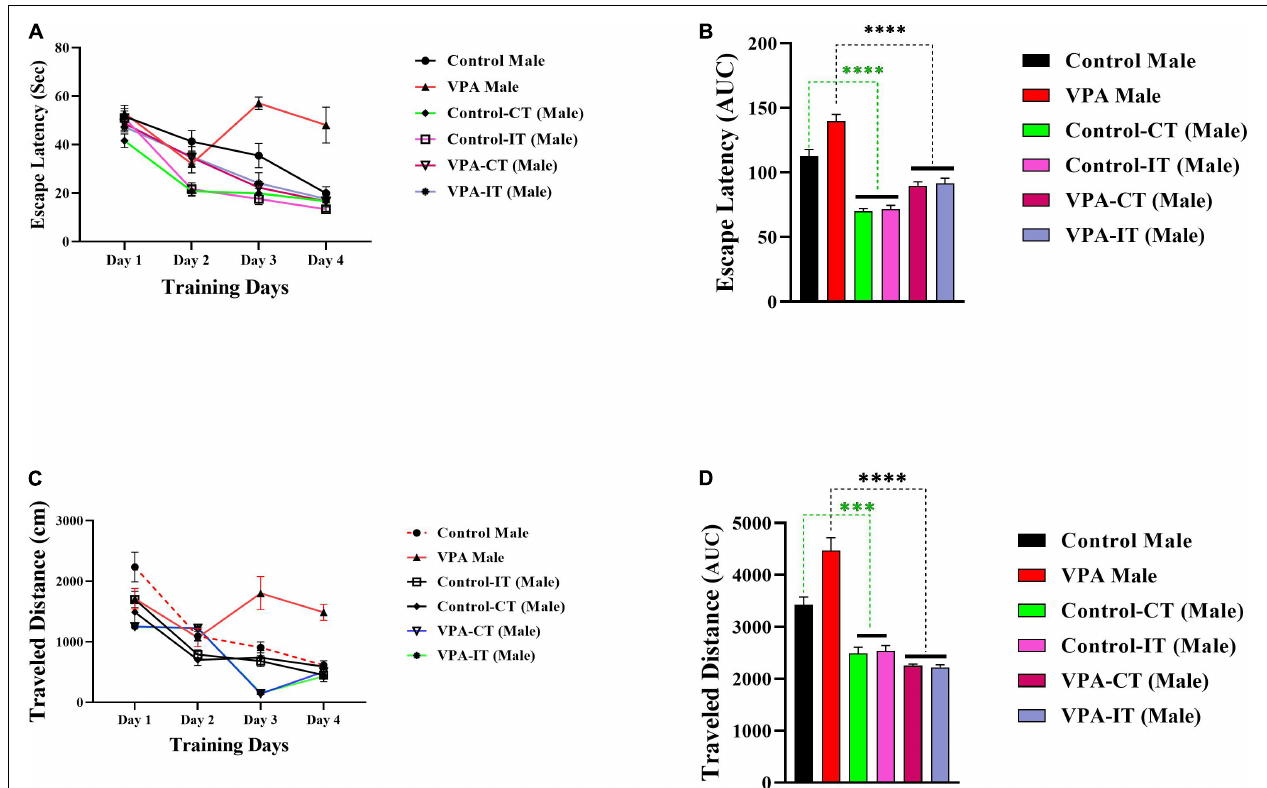
FIGURE 5 | The effects of IT or CT on the MWM acquisition in the control and VPA-exposed male offspring. IT and CT exercise trainings in both control and VPA-exposed male rats significantly reduced the escape latency (A) and traveled distance (C) . AUC for escape latency (B) traveled distance (D) in male rats. Data are presented as mean ± SEM. ∗∗∗ p < 0.001, ∗∗∗∗ p <